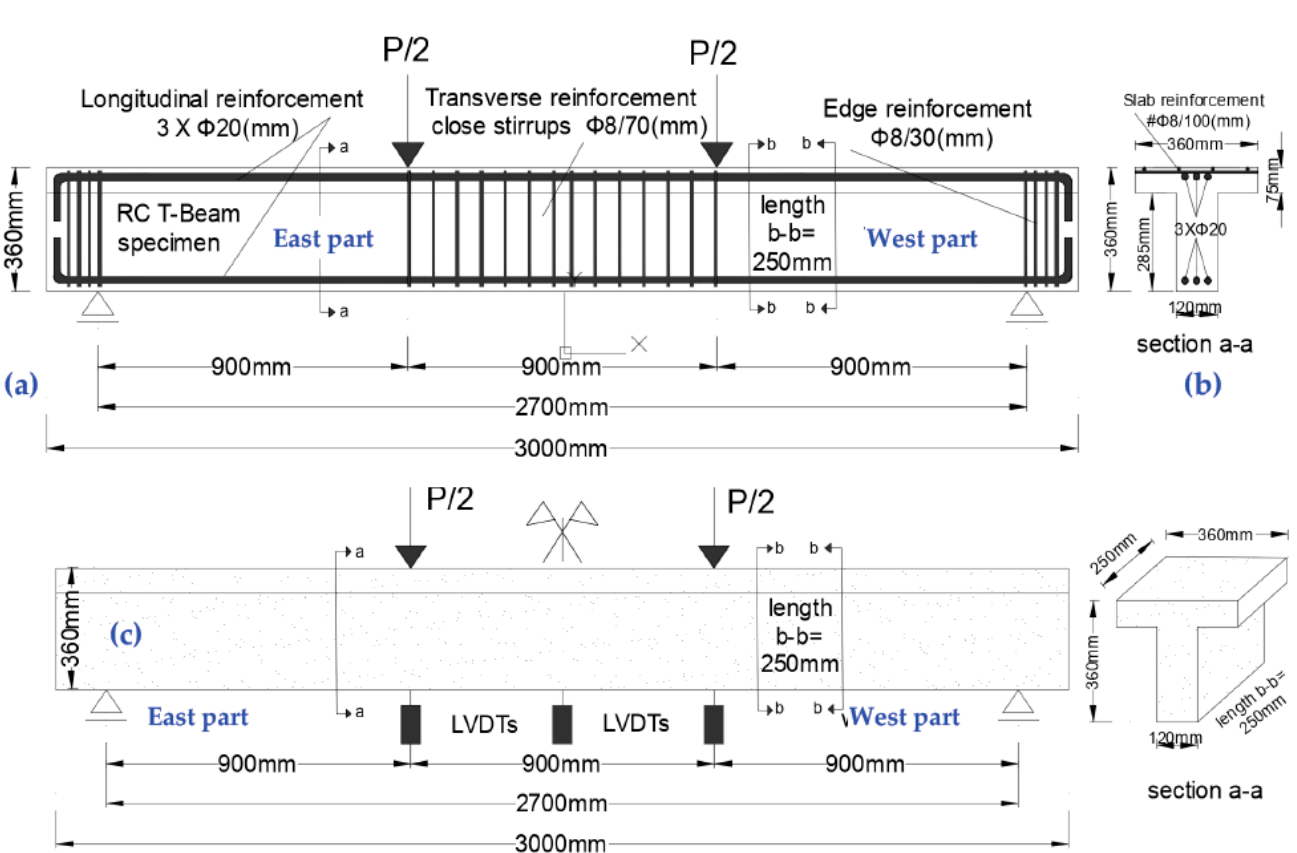
Figure 5. ( a ) Reinforcing details of RC T-beam specimen. ( b ) Cross-section RC T-beam specimen. ( c ) Four-point loading arrangement used in all tests together with the concept of forming the “unit T-beam” specimens (see also Figure 7a,b).